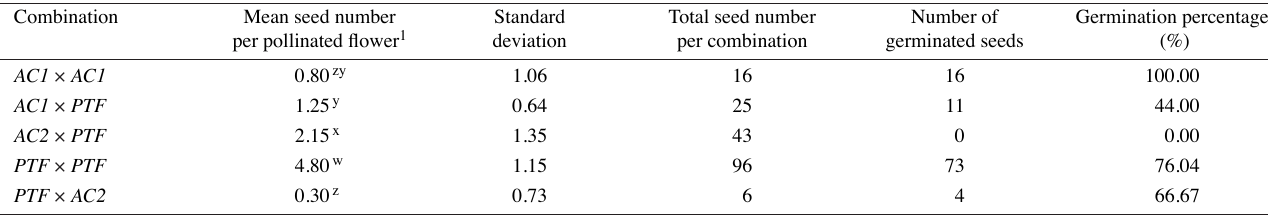
Tab. 5: Influence of the combination on the number of seeds and the germination percentage Combination Mean seed number